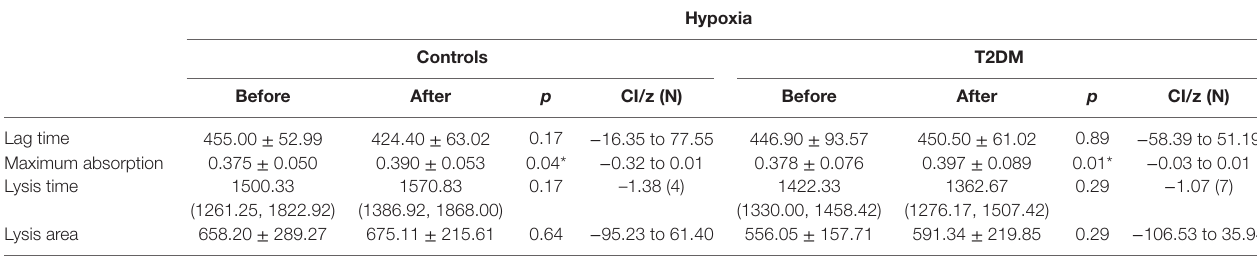
Table 2 | Clotting indices in healthy volunteers and participants with type 2 diabetes (T2DM) before and after simulated flight (SF) and exposed to oxygen concentration 15% and humidity